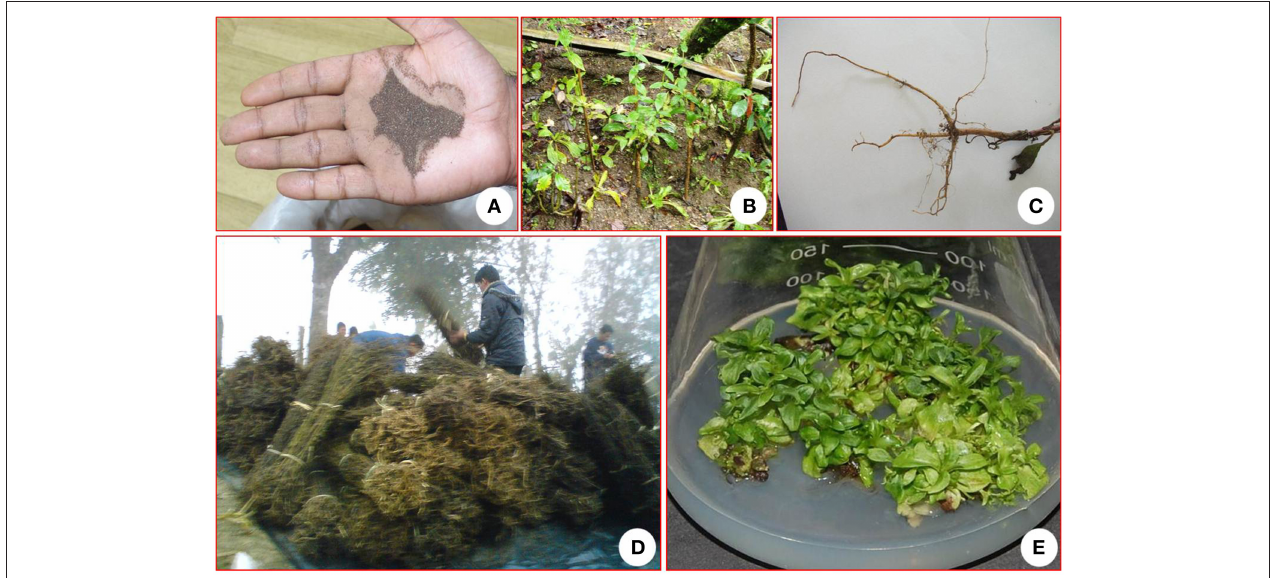
FIGURE 1 | Swertia chirayita. (A) Seeds, (B) Plant in nature, (C) Root of a mature plant, (D) Dry plant material, (E) High shoot multiplication in a plant tissue culture